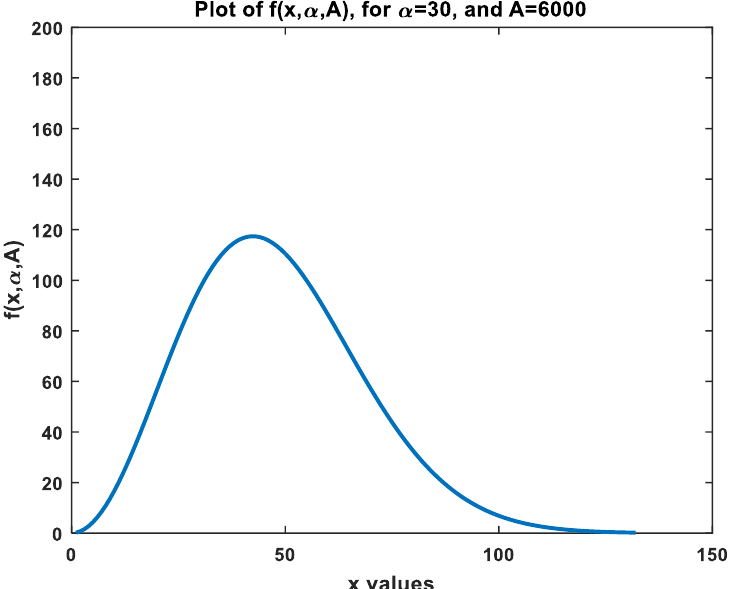
Figure-3. Modified Maxwell-Boltzmann distribution for a value of  =30 and